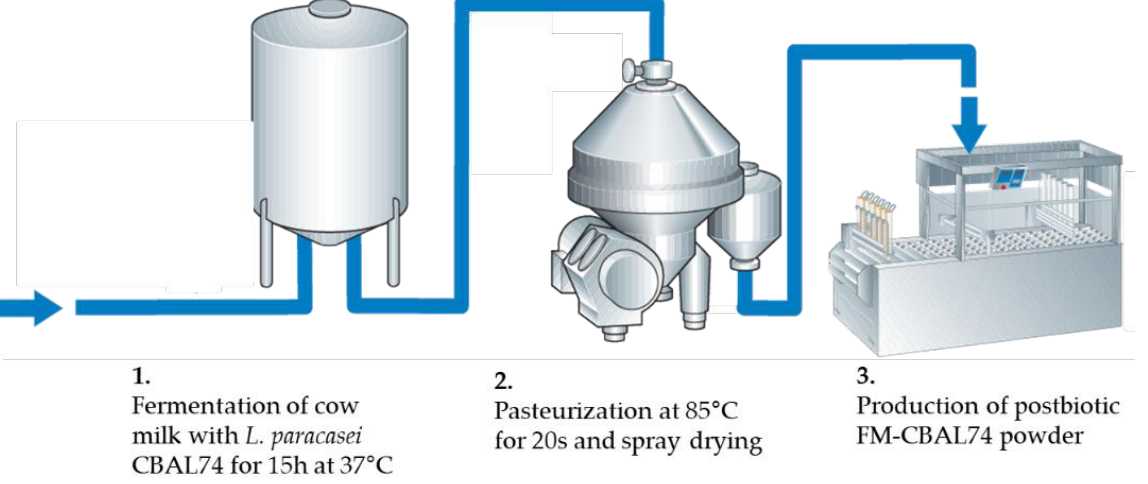
Figure 3. Schematic representation of the multistep process for the synthesis of the postbiotic FM-CBAL74. The FM-CBAL74 is obtained from skimmed cow milk fermentation with the probiotic L. paracasei CBAL74 . The first step is a thermal processing, pasteurization of the skimmed cow milk to obtain enzymatic, and microbiological stability. Then the fermentation is started in the presence of 10 6 CFU/gr L. paracasei CBAL74, reaching 5.9 × 10 11 CFU/g after 15 h incubation at 37 °C. Then, the product is pasteurized at 85 °C for 20 s and spray dried. Thus, the final fermented milk powder contains only bacterial bodies and fermentation products, but not living microorganisms.